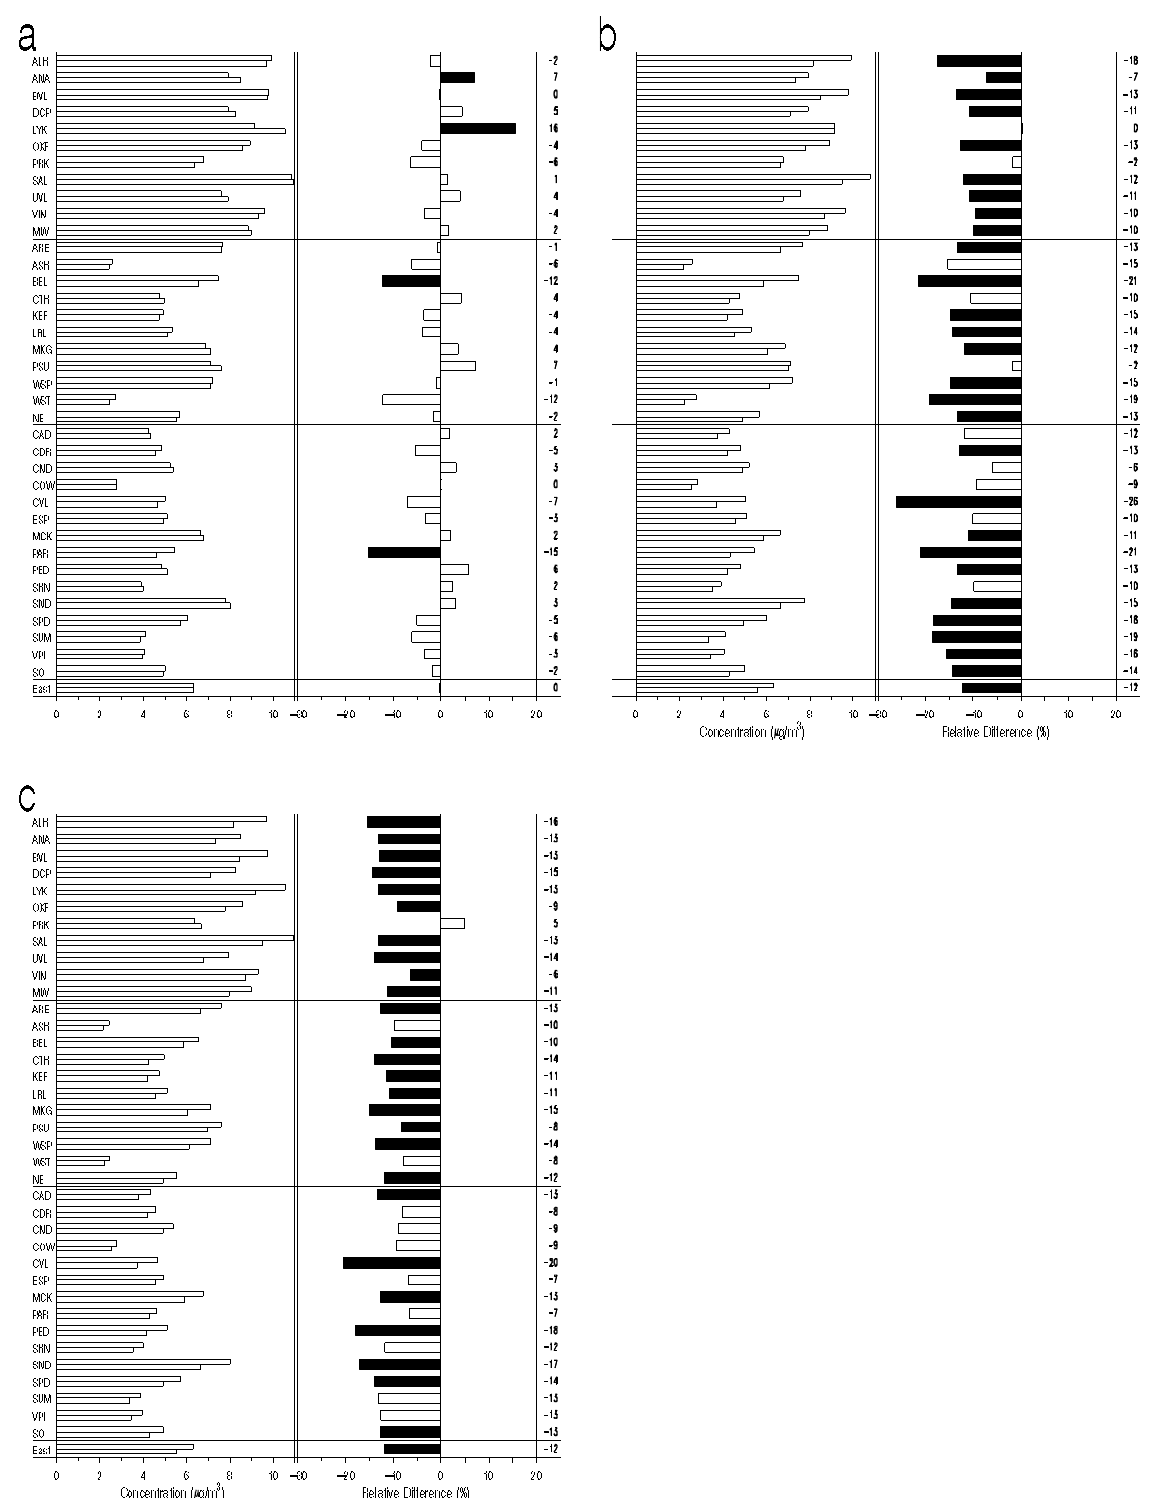
Figure 8. Site- and region-specific wintertime CASTNET PM concentration (µgm − 3 , left – upper bar: early period; and lower bar: later period) and period-to-period relative changes (%, right and bottom) for (a) P1-to-P3, W; (b) P1-to-P4, W; and (c) P3-to-P4, W. Significance level of period-to-period relative changes indicated by bar fill: black, p ≤ 0 . 05; and open, p> 0 . 05 (NS). Sites are identified by region in the same order as shown in Table